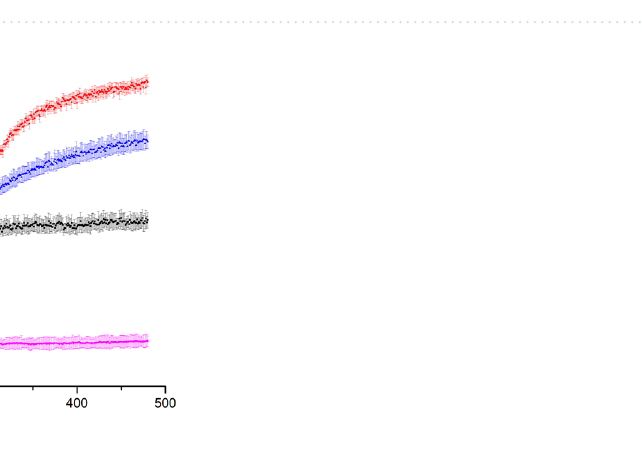
Figure 5. Quenching of the pH-dependent fluorophore ACMA at different Zn 2 + concentrations in proteoliposomes with ( a ) EcZntB (b ) TmCorA and ( c ) MjCorA (addition of Zn 2 + after baseline stabilization, black—50 μ M Zn 2 + , red—25 μ M Zn 2 + , blue—5 μ M Zn 2 + , green—1 μ M Zn 2 + , magenta—empty liposomes with 50 μ M Zn 2 + ). Error bars represent s.e.m. from three or more technical replicates of independent batches of proteoliposomes.